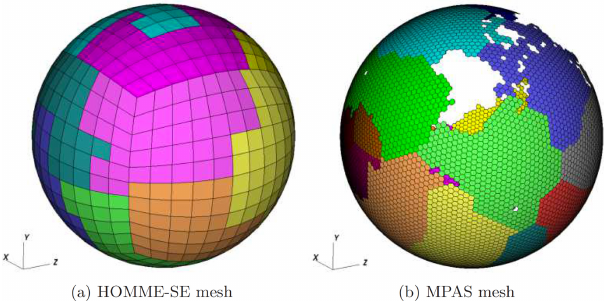
Figure 3. MOAB representation of partitioned component meshes.